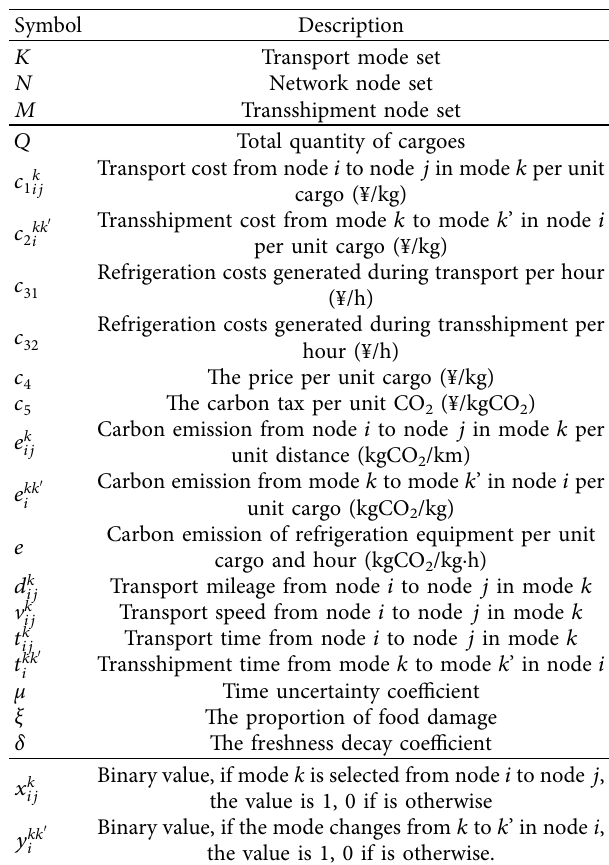
Table 1: Subscripts and parameters used in mathematical